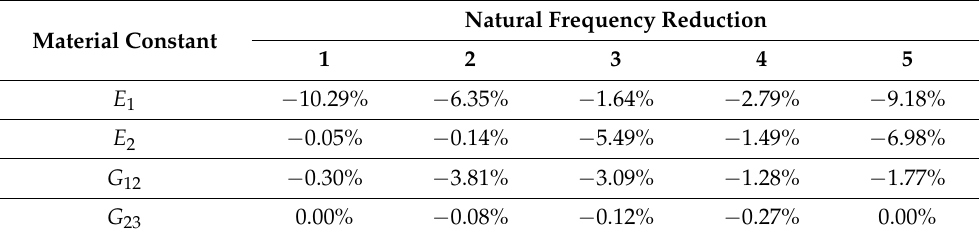
Table 10. Percentage changes in natural frequency induced by reductions in the material constants of a graphite/epoxy plate ( a / h =